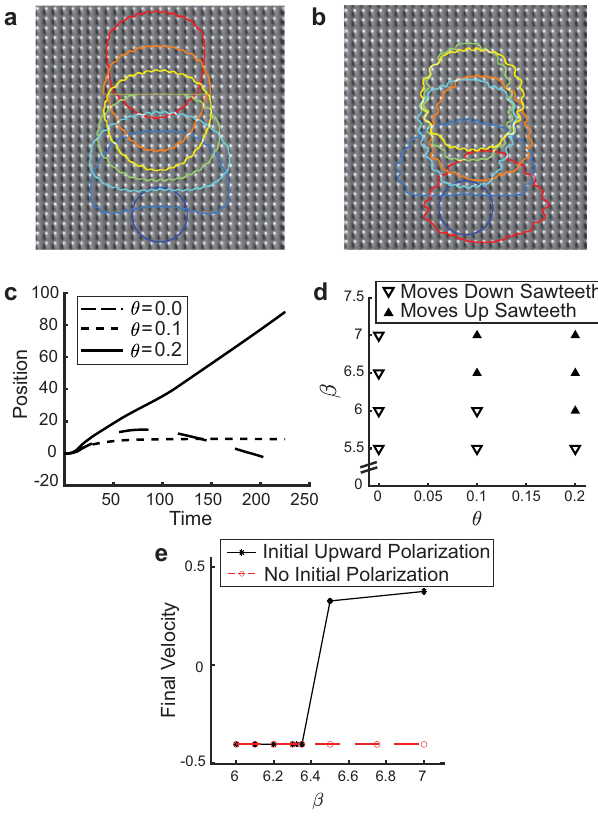
Fig. 2 Reversal of direction and evolution of shape phenotype. a A cell guided unidirectionally up the sawteeth following initial polarization up the sawteeth. b Decreasing the actin polymerization rate leads to a trajectory in which the cell initially moves up the sawteeth but then turns around. c Trajectories represent the three most common outcomes when a cell on the sawteeth is polarized up the sawteeth. d A phase diagram showing how the guidance direction depends on the actin polymerization rate β and the angle θ of actin polymerization relative to the substrate. The cell moves up the sawteeth when both β and θ are in the larger range of the values examined here. e The asymptotic guidance velocity exhibits hysteresis for θ = 0.1. For cells with an initial polarization, the transition from moving up the sawteeth to moving down the sawteeth is sudden. For unpolarized cells, guidance is only observed down the